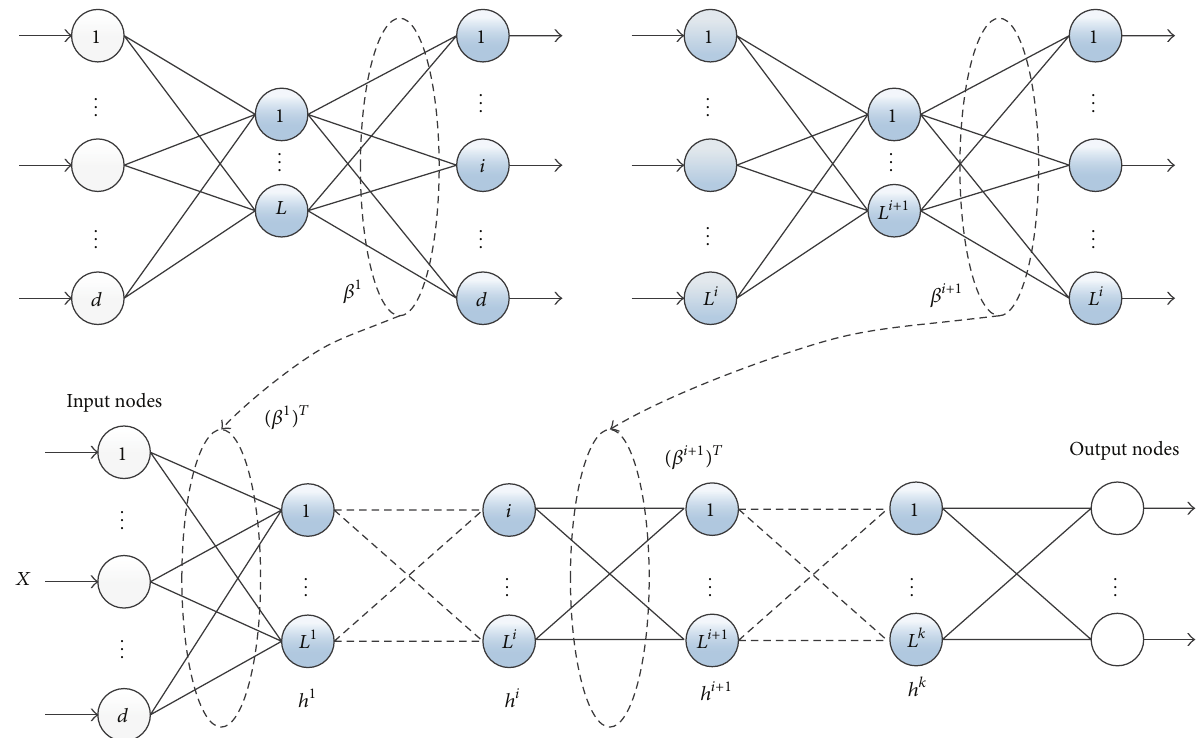
Figure 2: Construction of multi-hidden-layer